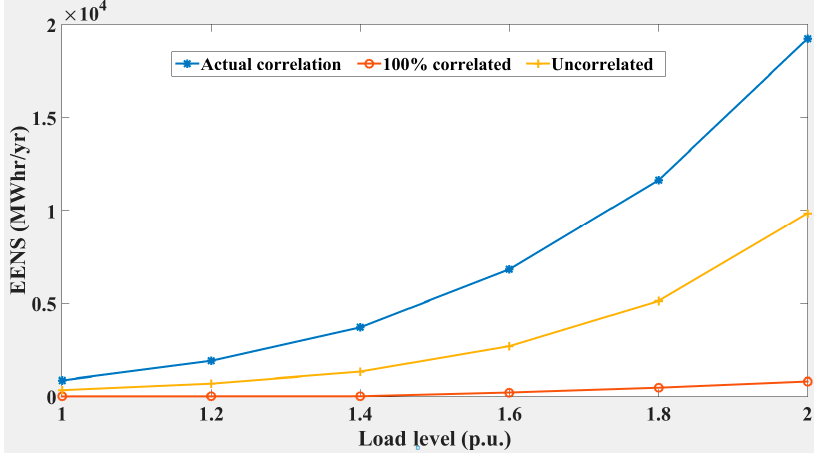
Figure 10. The EENS of BusSectorLS80 with various DTR system correlations.